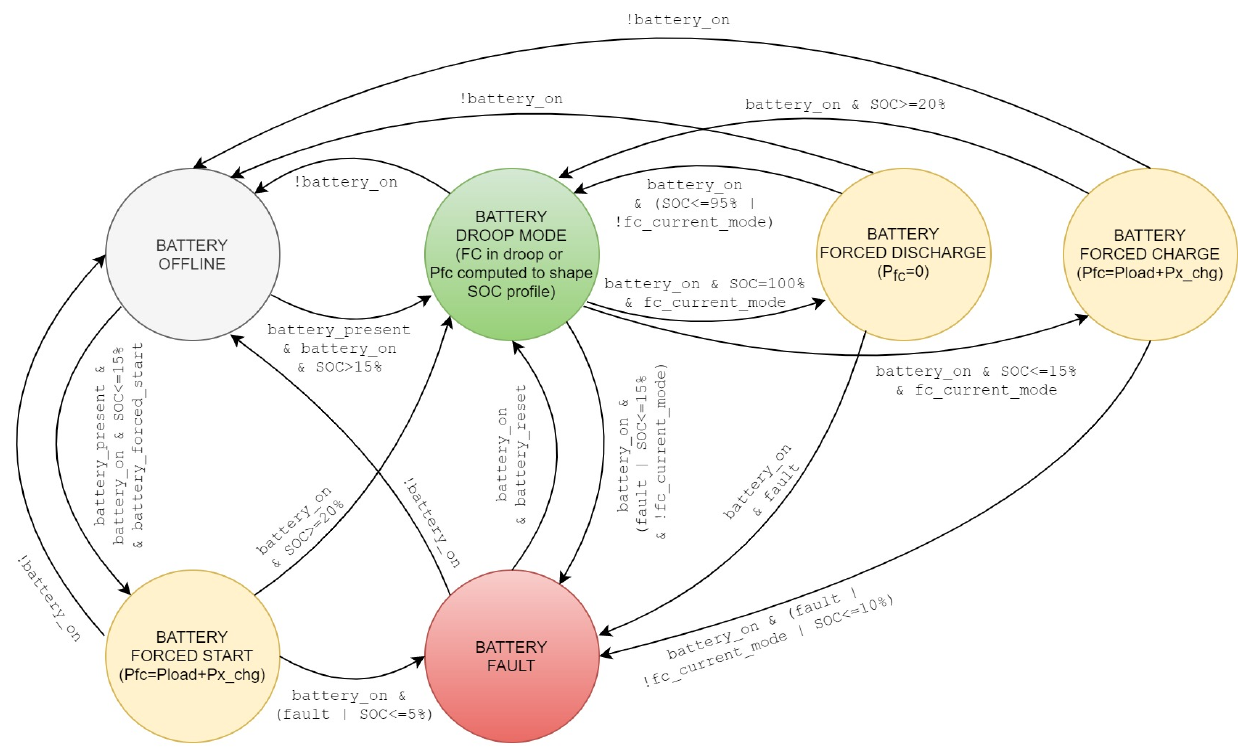
Figure 6. State diagram of the battery FSM.